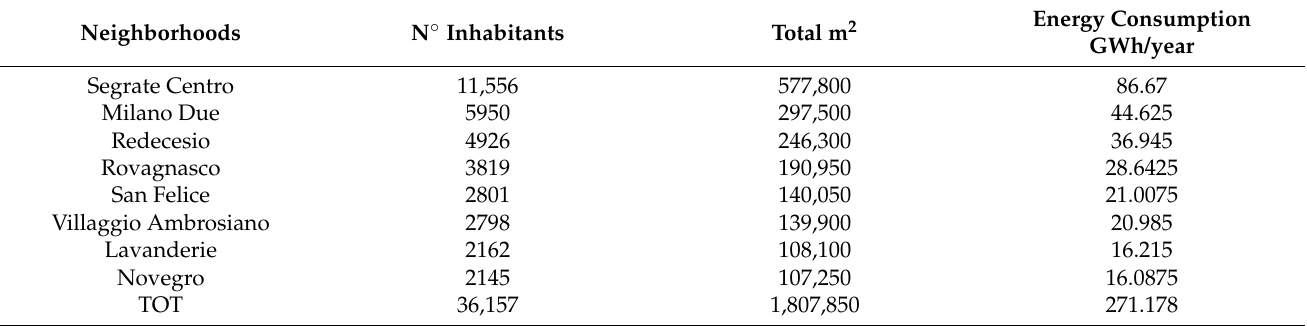
Table 2. Energy consumption for heat carrier for each Segrate neighborhood.